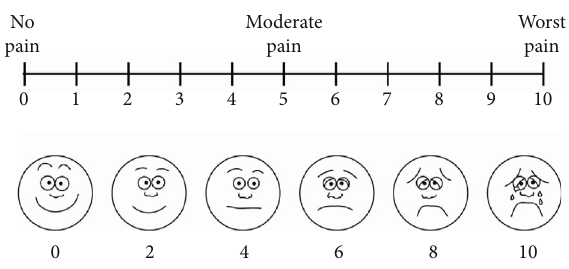
Figure 6: Visual analogue scale to assess pain perception and verify patient